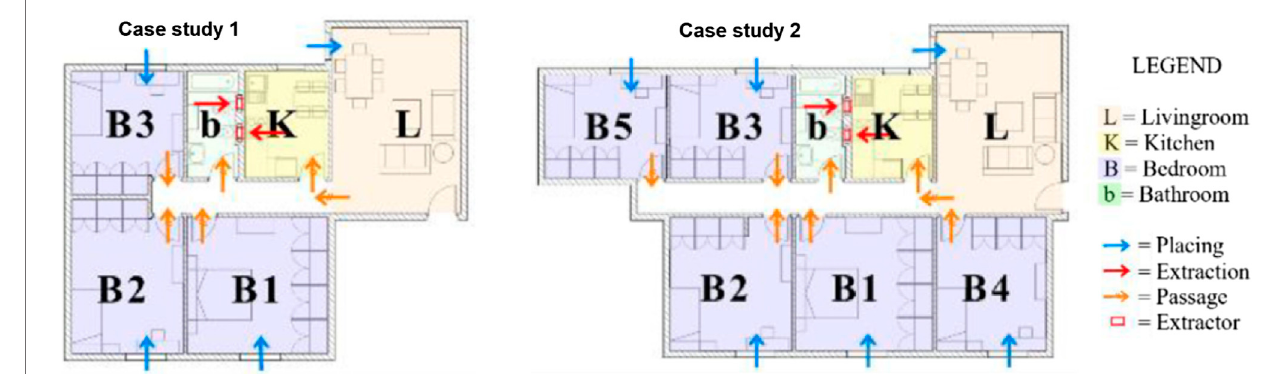
FIGURE 1 | Case study 1 and 2: housing with minimum and maximum fl oor areas.